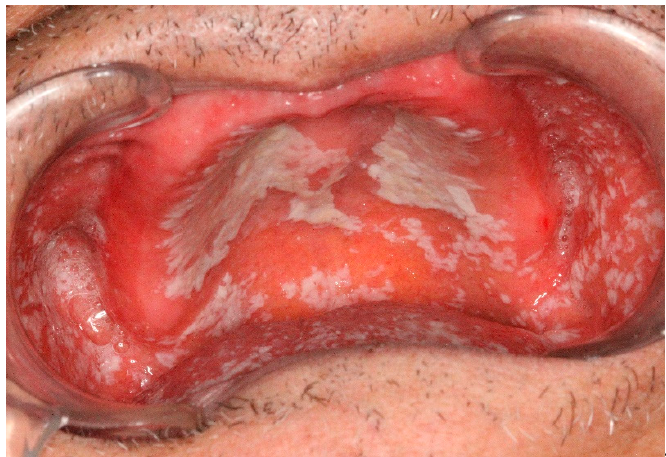
Figure 4. Pseudomembranous candidiasis due to using broad spectrum antibiotic; pseudo membranes can be scraped off by a piece of gauze.